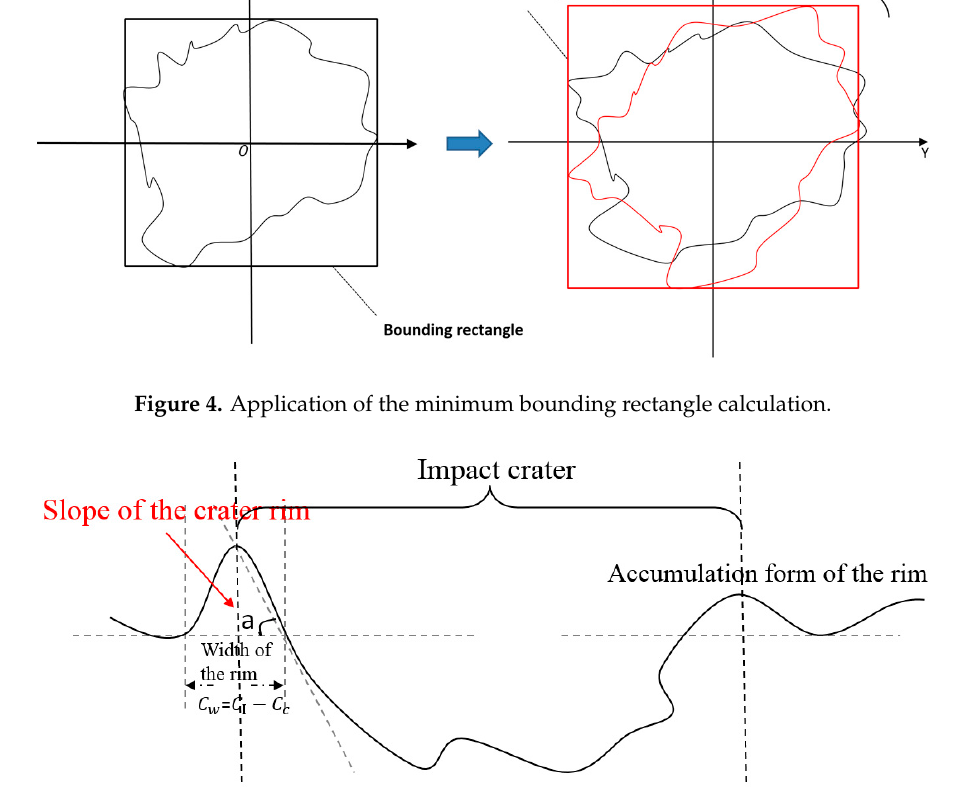
Figure 5. Schematic description of some of the indices in Table 2.